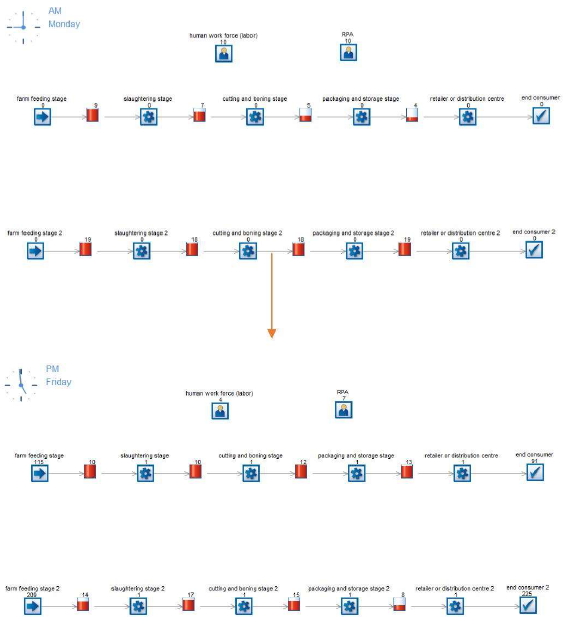
Figure 10. Simulated model—comparison of scenarios 1 and 2 modelled using Simul8.